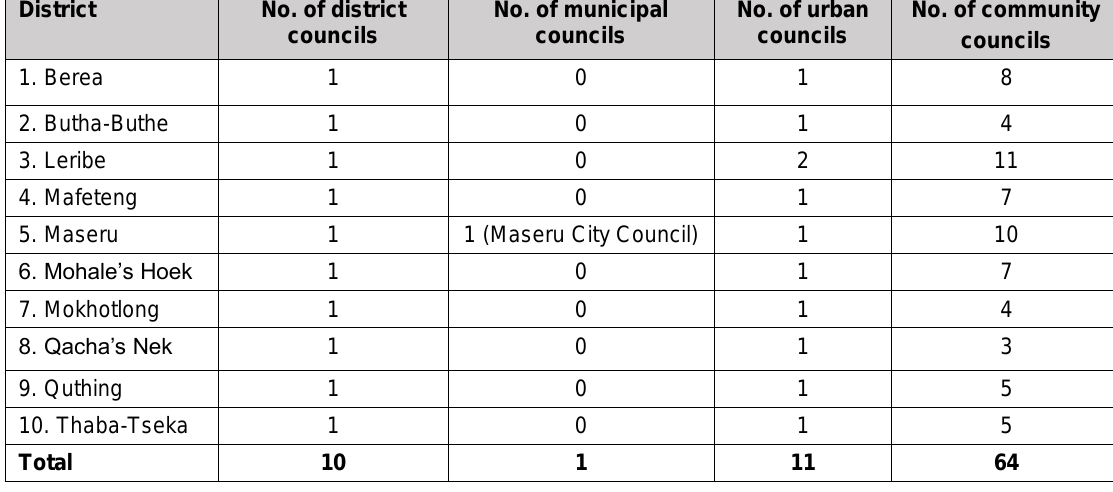
Table 1: Types and number of local